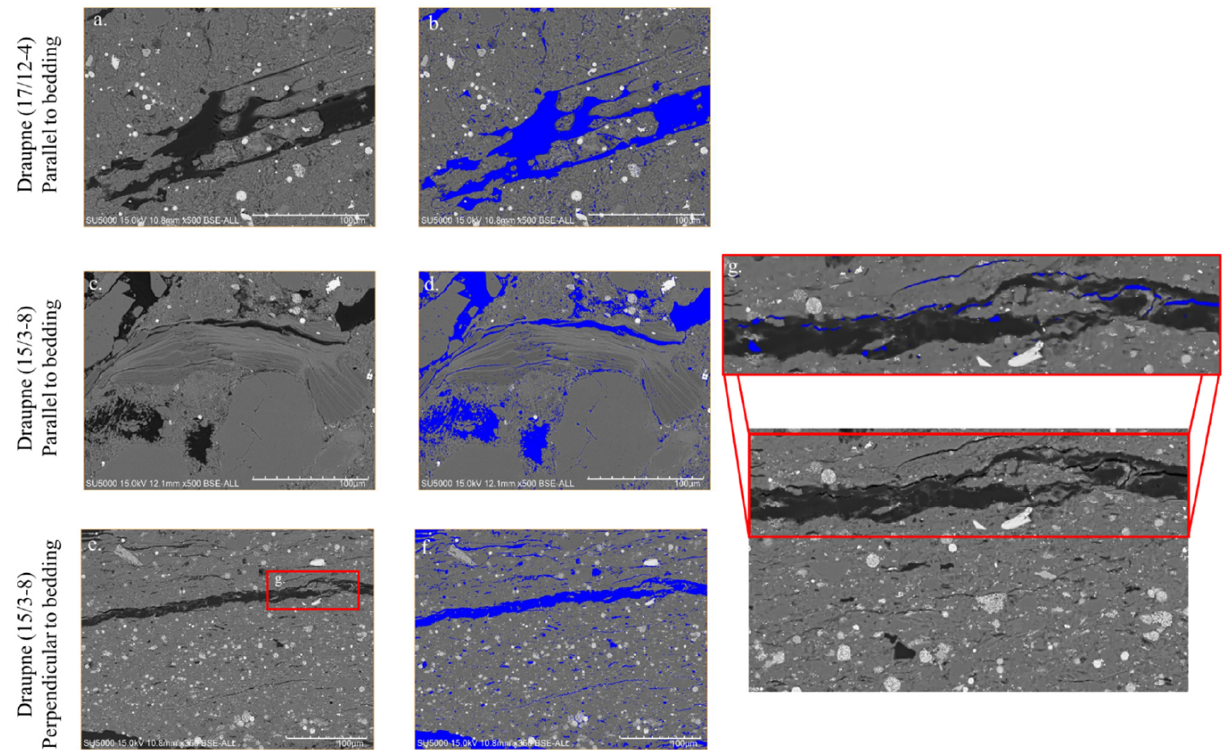
Figure 11. 3D tomographical images at 0.7 µm/voxel from both the Draupne (16/8-3 S) and Hek- kingen Formations (7125/1-1). ( a , b ) Grayscale orthoslices highlighting fractures and kerogen lenses in black, ( c , d ) with 3D realization of just kerogen lenses, and ( e , f ) 3D realizations of kerogen lenses and branching microfractures.